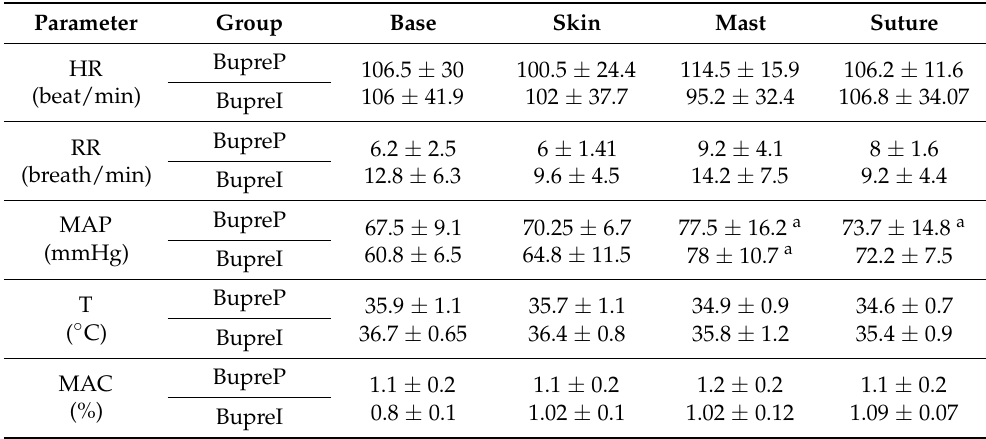
Table 3. Mean ± SD of the intraoperative parameters ten minutes before the start of surgery (BASE) and during the incision of the skin (SKIN), the mammal line traction and dissection (MAST), and the suture of the subcutaneous plane (SUTURE). a p < 0.05 compared with BASE.